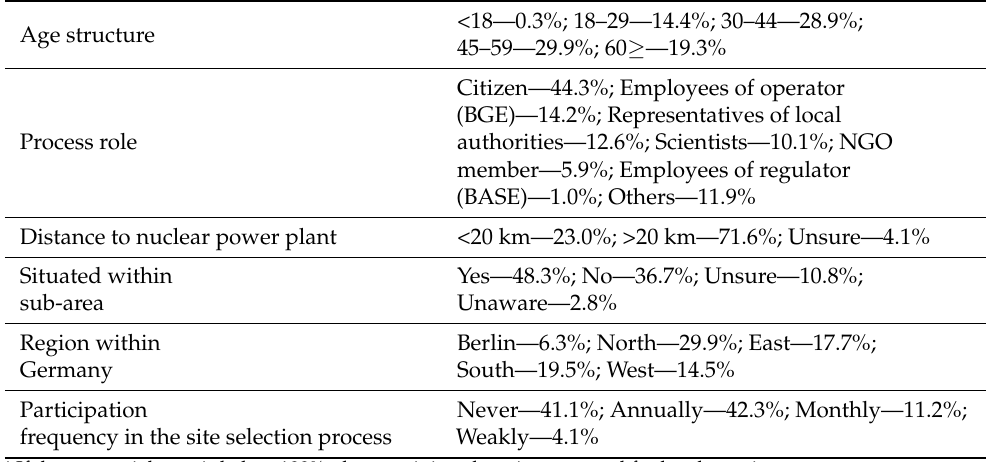
Figure 1. Spatial Distribution of the Survey Respondents based on the Postal Code (own data). Table 2. Sample composition * (own